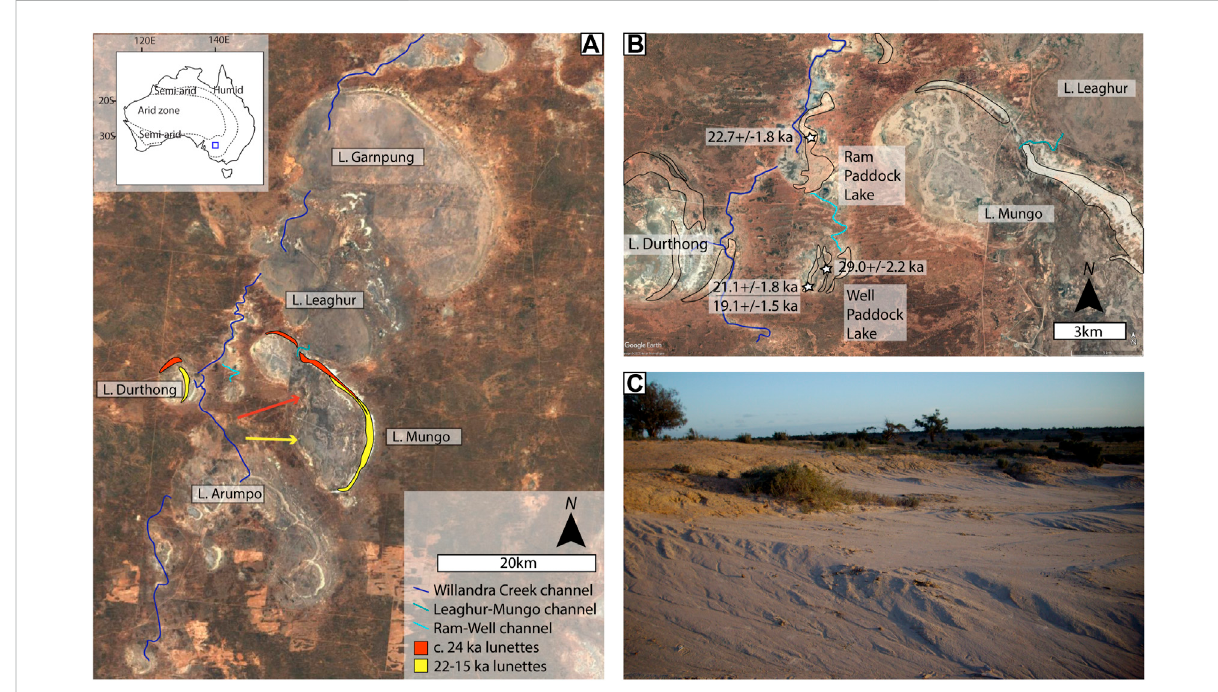
FIGURE 1 Location, context and chronology of RPL and WPL within the Willandra Lakes system. (A) Location of the Willandra Lakes in semi-arid southeasternAustralia(inset)andthelakessystem,includingtheWillandraCreekandinterconnectingchannels.Theextentofmaximumthicknessof the c. 24 ka and 22 – 15 ka lunettes at Lakes Durthong and Mungo, along with the proposed prevailing wind vectors active during those depositional phases (Fitzsimmons, 2017),are also shown. (B) Local context, including lunette outlines, and chronology of thesampling sites atRPLand WPL. (C) The WPL inner lunette, photographed looking south. Base images sourced from Google